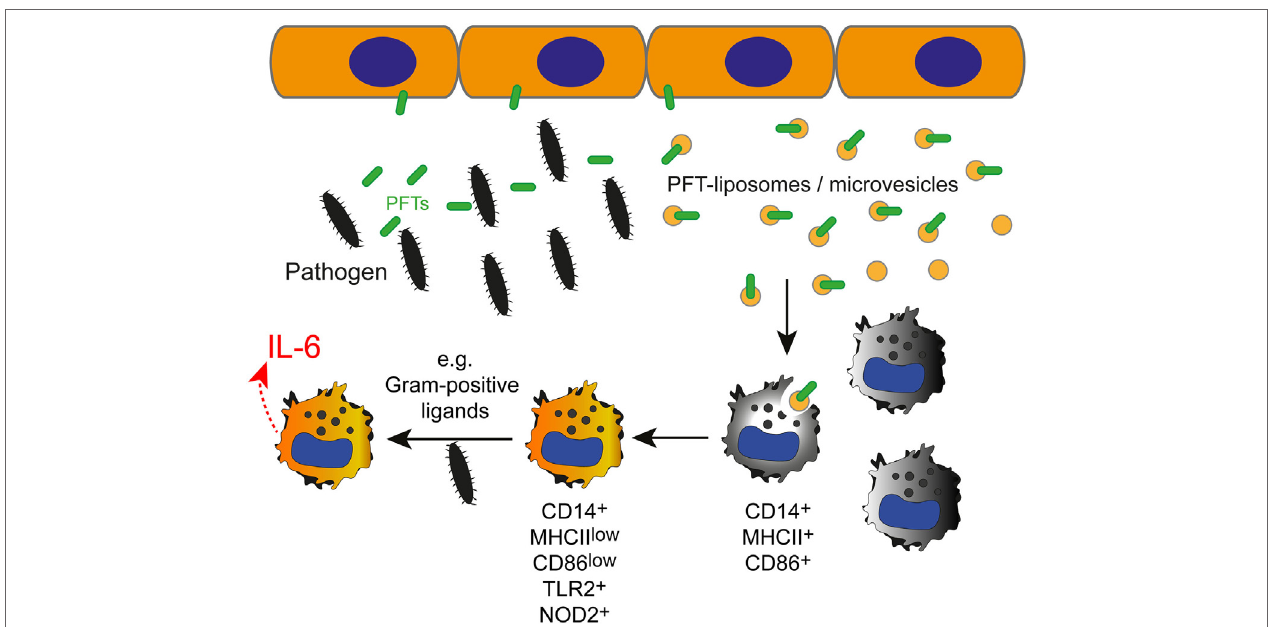
FigUre 6 | The effect of inactivated pneumolysin (PLY)-pores on macrophages in an inflammatory environment. Pore-forming toxins (PFTs), such as PLY perforate the plasmalemma of host cells. Membrane repair is initiated and toxin pores are shed into the extracellular space in the form of microvesicles (7). Alternatively, the administration of specific liposomes sequesters the pore-forming toxin and protects the host cell from injury (34). PLY-pores on liposomes or on microvesicles (PFT-liposomes/microvesicles) are sensed by macrophages and prime macrophages to preferentially react against pore-forming toxin-producing Gram-positive bacteria, i.e., Streptococcus pneumoniae , with an increased production of IL-6 in response to PRR ligation (i.e., TLR2, NOD2) by Gram-positive